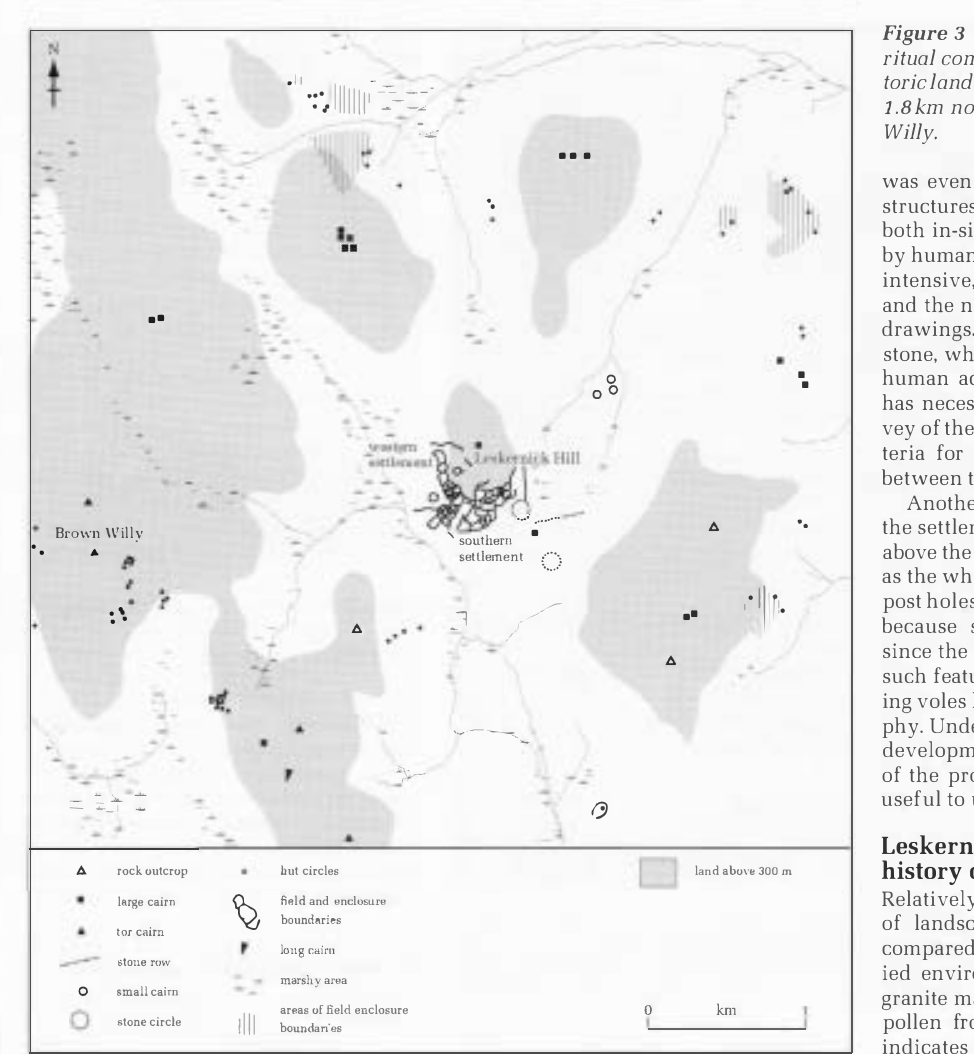
Figure 3 The Leskernick settlement, ritual complex and surrounding prehis­ toric landscape. Rough Tor lies off the map 1.Bkm northwest of the summit of Brown Willy